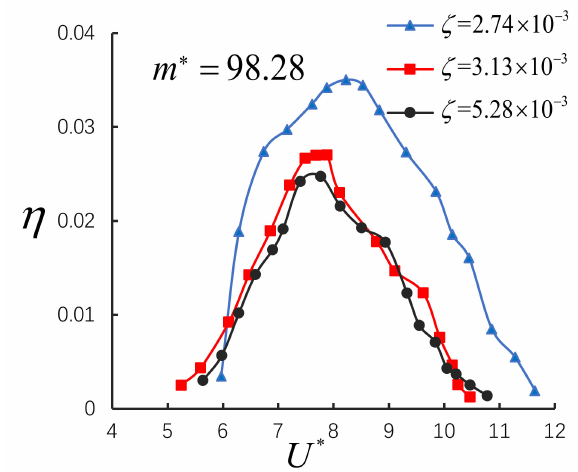
Figure 7. η with the change of U ∗ of experiment II.